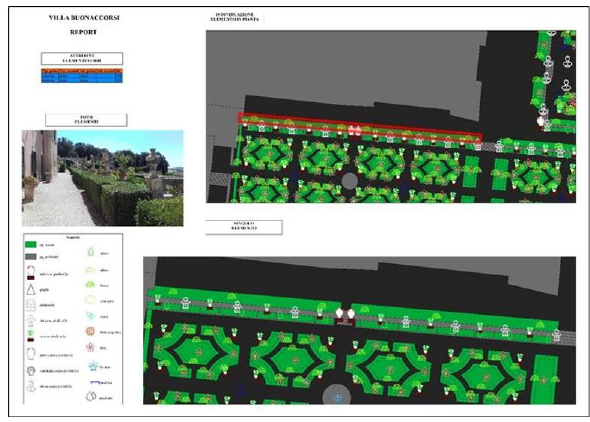
Figure 12. An example of report